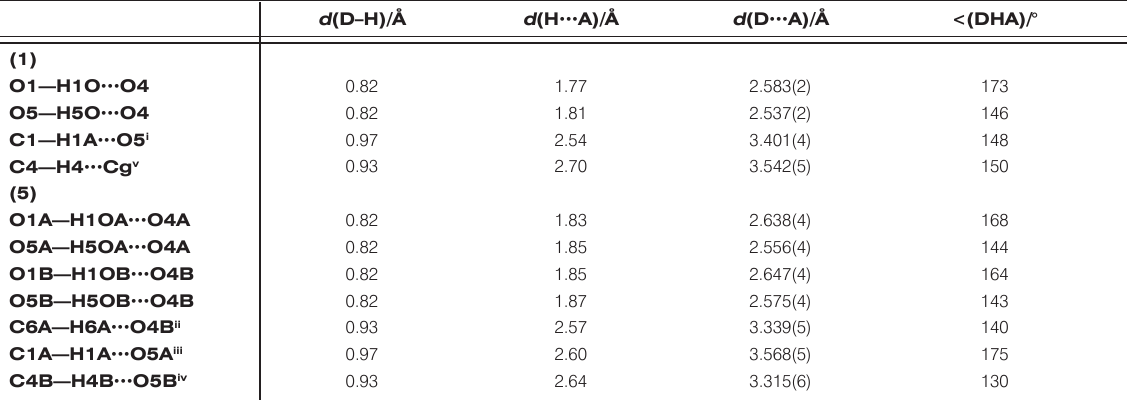
Table 4. Parameters of hydrogen bonds within the structure.